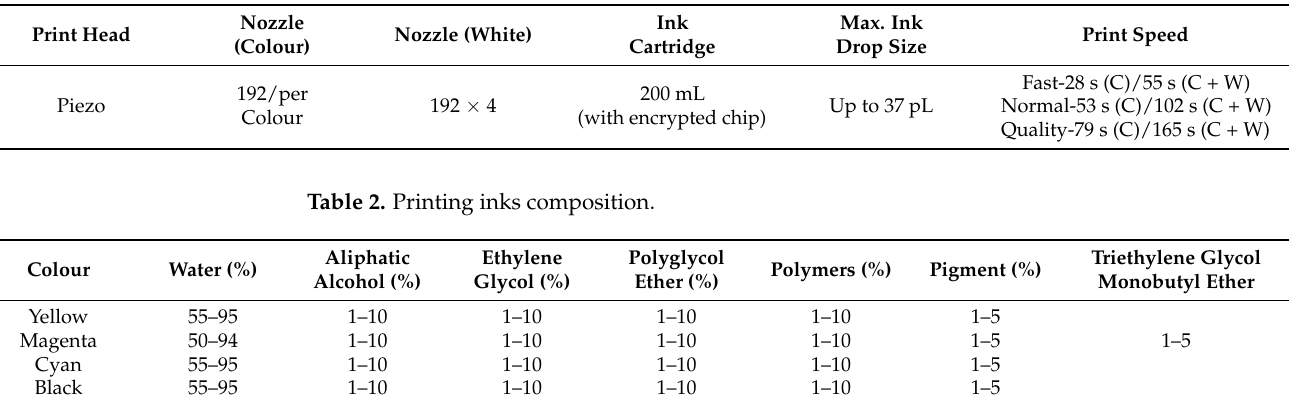
Table 1. Inkjet textile printing machine technical characteristics.